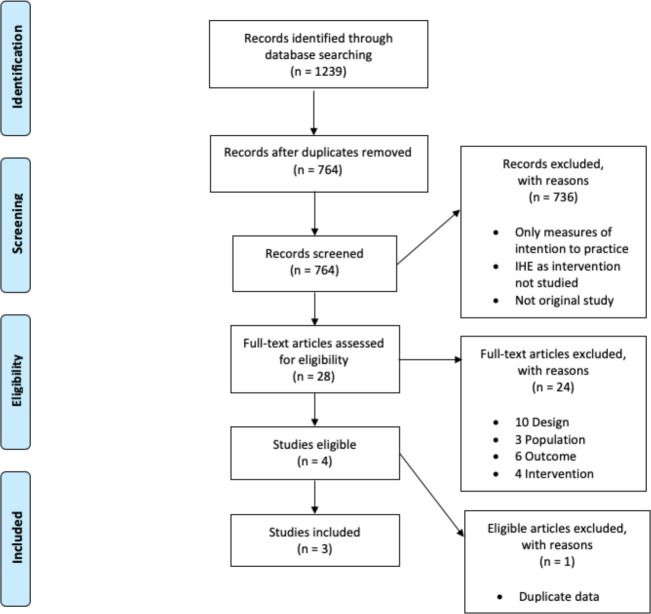
PRISMA flow diagram of study selection process.